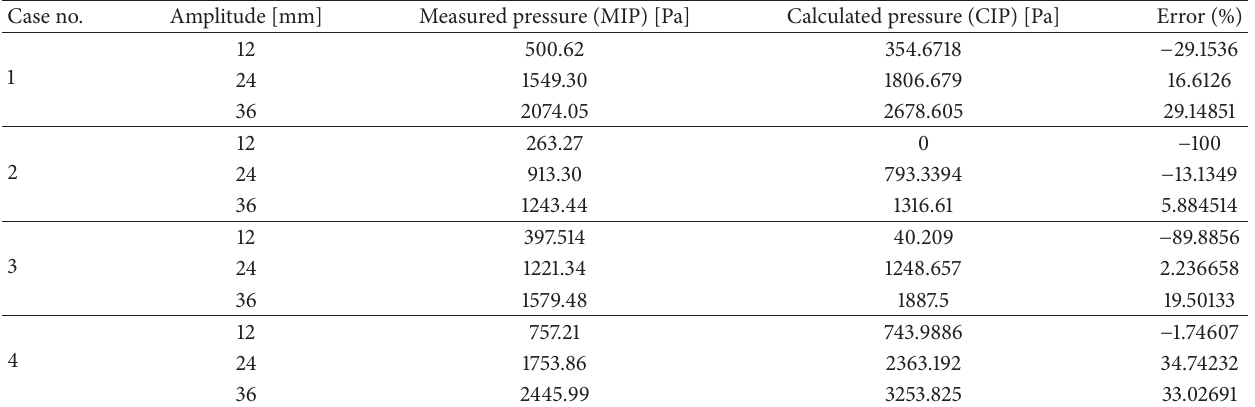
Table 5: The comparison between calculated pressure and measured pressure. Case